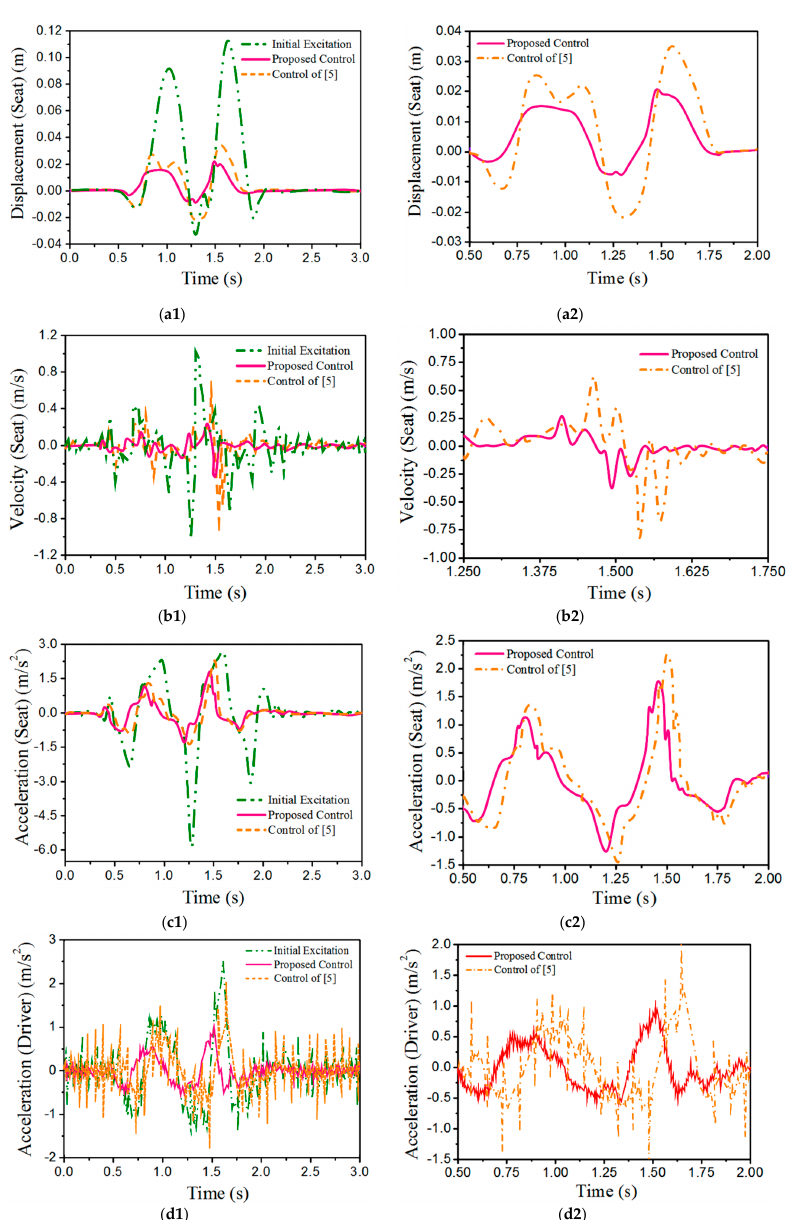
Figure 7. Experiment results under regular bump excitation: ( a1 ) displacement; ( a2 ) enlarged view of the displacement; ( b1 ) velocity; ( b2 ) enlarged view of the velocity; ( c1 ) acceleration at the seat; ( c2 ) enlarged view of acceleration at the seat; ( d1 ) acceleration of the driver; ( d2 ) enlarged view of the acceleration of the driver.